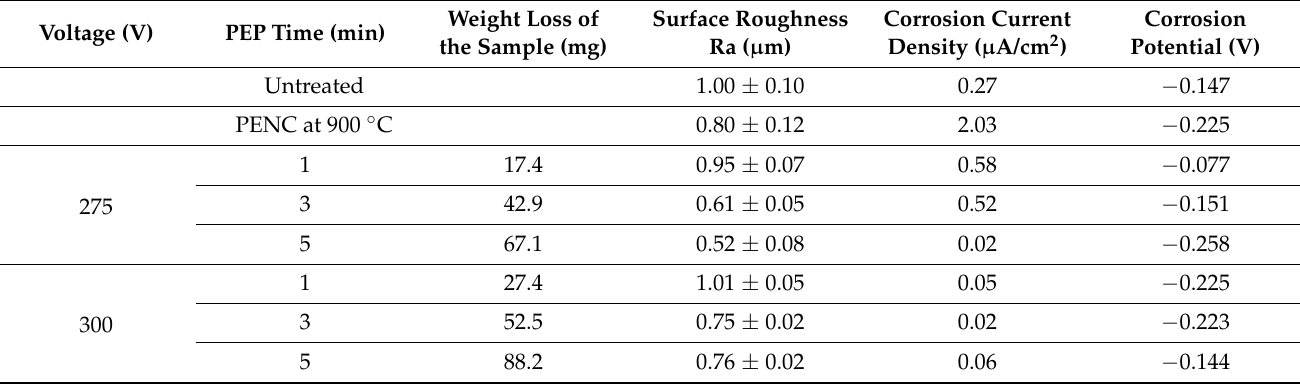
Table 4. Values of weight loss, surface roughness, corrosion current density and corrosion potential of CP-Ti samples after anodic PENC at 900 ◦ C and subsequent PEP in a solution of ammonium fluoride